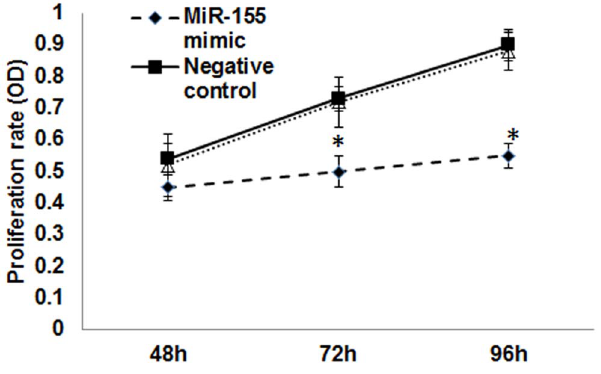
Figure 5. Upregulation of miR-155 decreases cellular prolifer- ation in VSMC from CKD rats. Rat VSMC isolated from CKD rats were transfected with 30 nM of miR-155 mimic or miR negative control. Non- transfected VSMC (NT) was also used as control. The cellular proliferation was determined 48, 72 and 96 hrs after transfection using Cell Titer 96 Proliferation Assay Kit. The results demonstrated that the transfection of miR-155 mimic significantly inhibited cellular prolifera- tion at 72 and 96 hrs in VSMC from CKD rats compared to that with negative control or non-transfected VSMC. Data were expressed as mean 6 SEM (n=3 separate experiments). *p , 0.05, miR-155 mimic vs. negative control or NT.